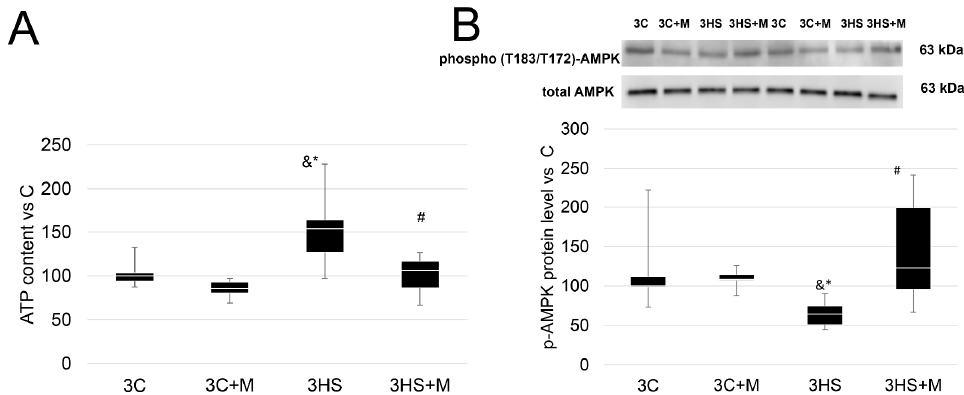
Figure 1. ATP content ( A ) and p-AMPK α 1/2 (T183/T172) protein level ( B ) in rat soleus muscle of the control group (3C), the control group with metformin (3C+M), the 3-day hindlimb-suspended group (3HS), and the 3-day hindlimb-suspended group with metformin (3HS+M). Data are shown as % of the control group, and median of the C group has been arbitrarily set to 100%. *—significant difference from the control group. &—significant difference from 3C+M group. #—significant difference from 3HS group ( p < 0.05). Box plots show 25–75 percentiles and median values and the whiskers represent the minimum and the maximum; n = 8/group. After 7 days of HS p-AMPK (T183/172), the protein level did not differ among the experimental groups. At the same time, in the 7HS group, the protein level of the AMPK target, p-ACC (Ser 79), was lower compared with the C and C+M groups. In the 7HS+M group, the protein level of p-ACC did not differ from the C or C+M rats. The C and C+M rats’ results did not differ from one another (Figure 2).